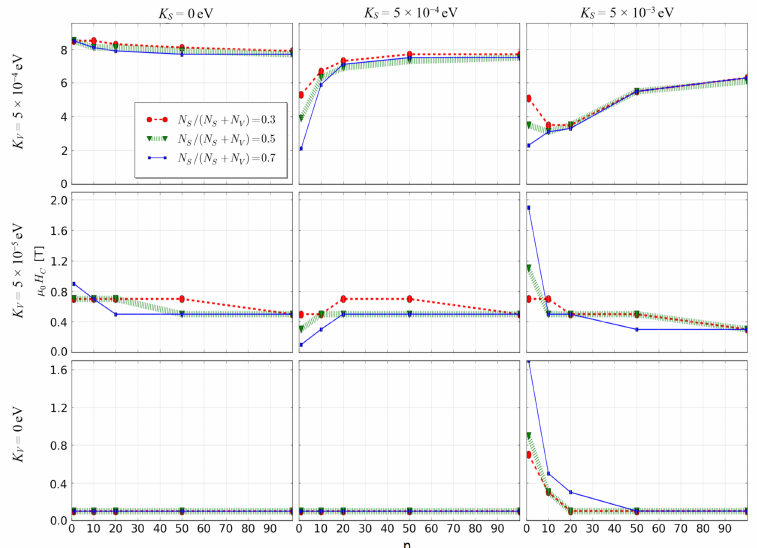
Figure 3. Coercive field H C as a function of the scaling factor for all studied cases with S =